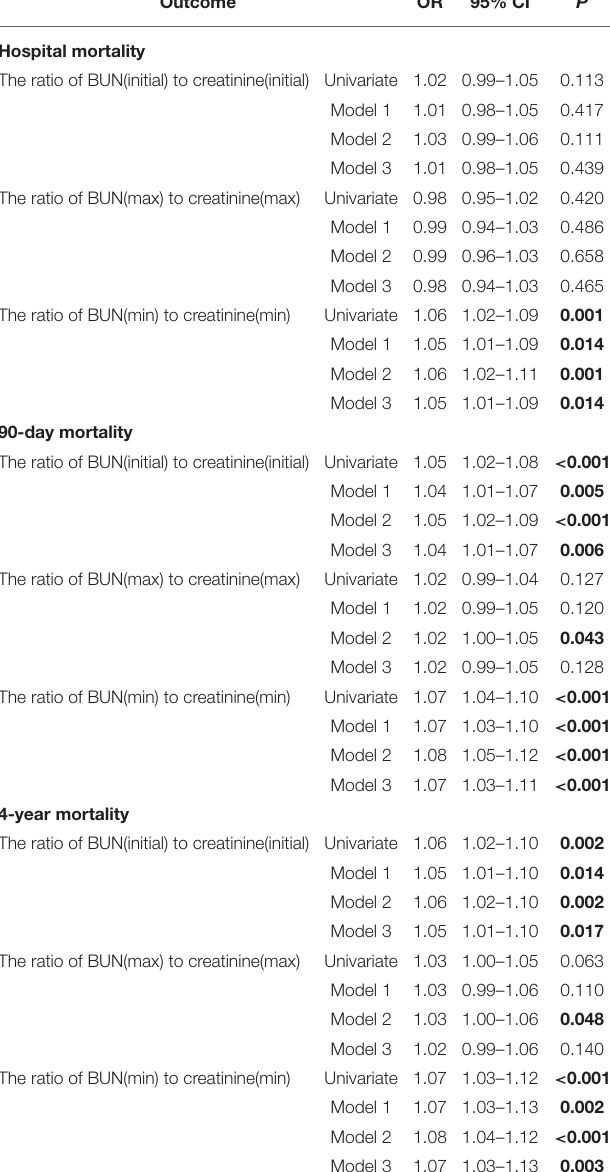
TABLE 8 | Association between the ratio of BUN to creatinine with prognosis of PPH patients. Outcome OR 95% CI P Hospital mortality The ratio of BUN(initial) to creatinine(initial) Univariate 1.02 0.99–1.05